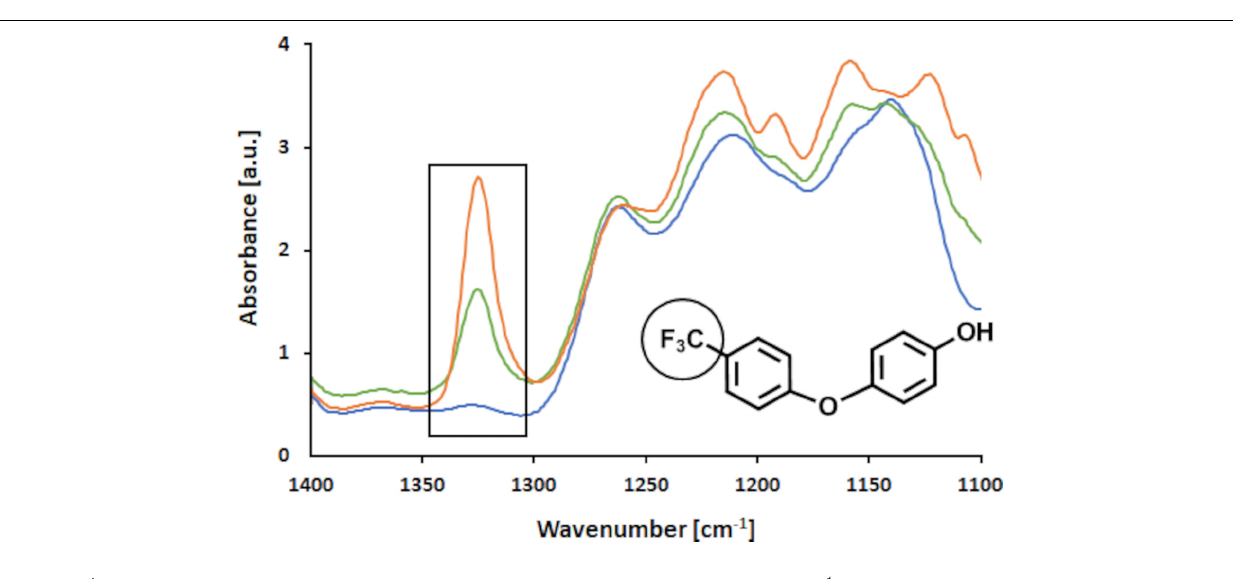
FIGURE 9 | FTIR analysis of enzymatic coupling of FP to LS. FTIR spectrum in the range of 1,400–1,100 cm - 1 , where the band of the –CF 3 group is located. The control sample (blue), 1% (w/v) FP sample (green) and 2% (w/v) FP sample (orange) are shown. TABLE 1 | Results of XPS analyses of the laccase catalyzed coupling of FP onto LS.